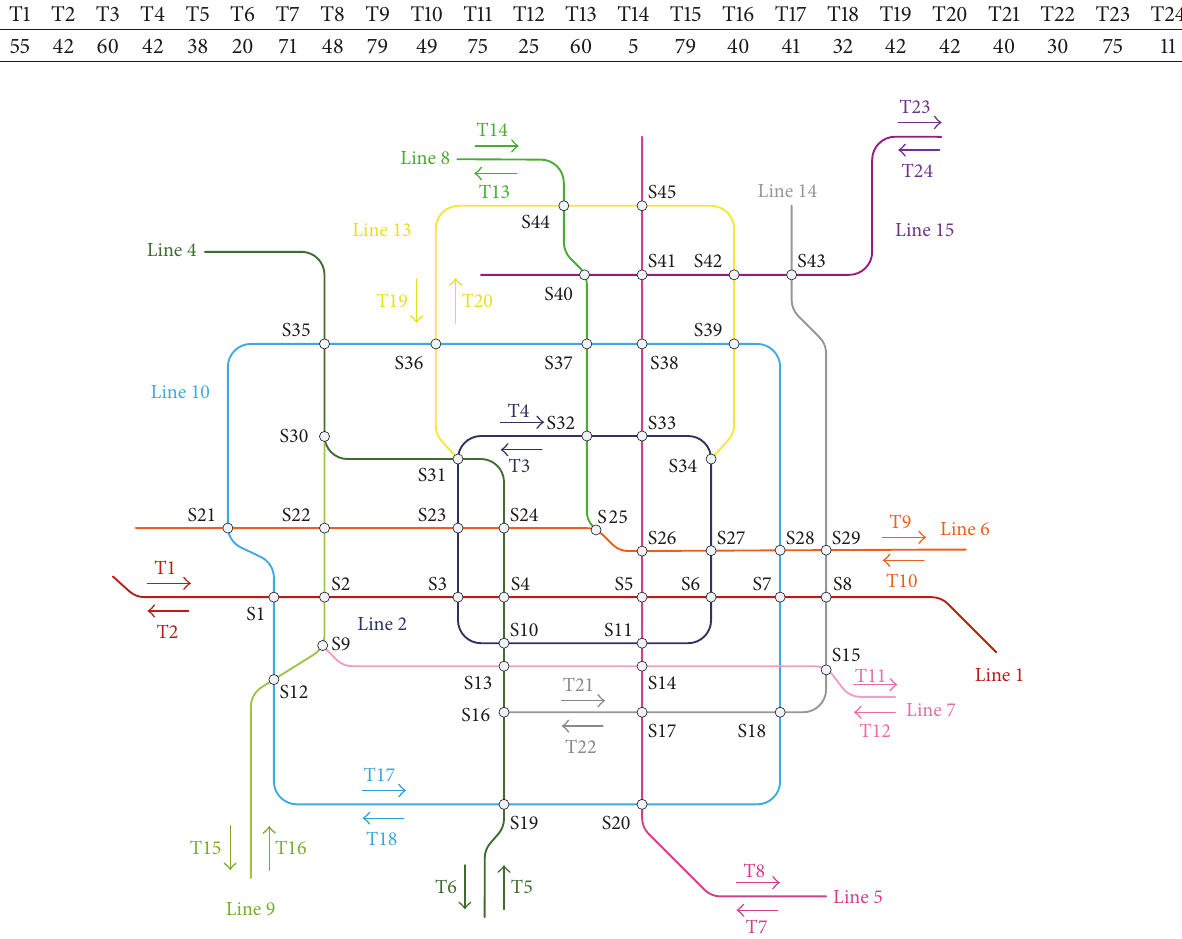
Figure 5: Simplified Beijing Subway